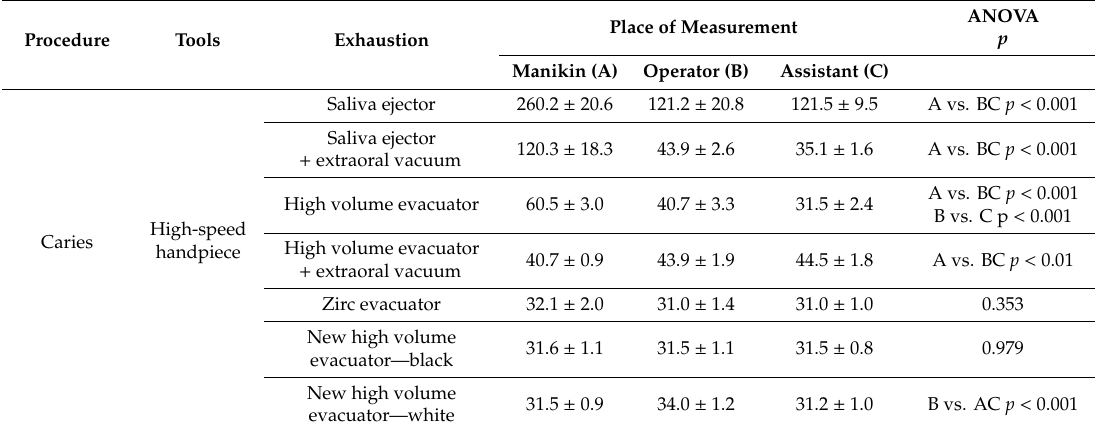
Table 1. The amount of aerosol ( × 10 3 ) measured at the three sites (mean ± SD) during caries removal using the high-speed handpiece with; A. Saliva ejector. B. High volume evacuator. C. Saliva ejector with an extraoral vacuum. D. High volume evacuator with an extraoral vacuum. E. Zirc ® evacuator. F. Customized high volume evacuator (white). G. Customized high volume evacuator (black).